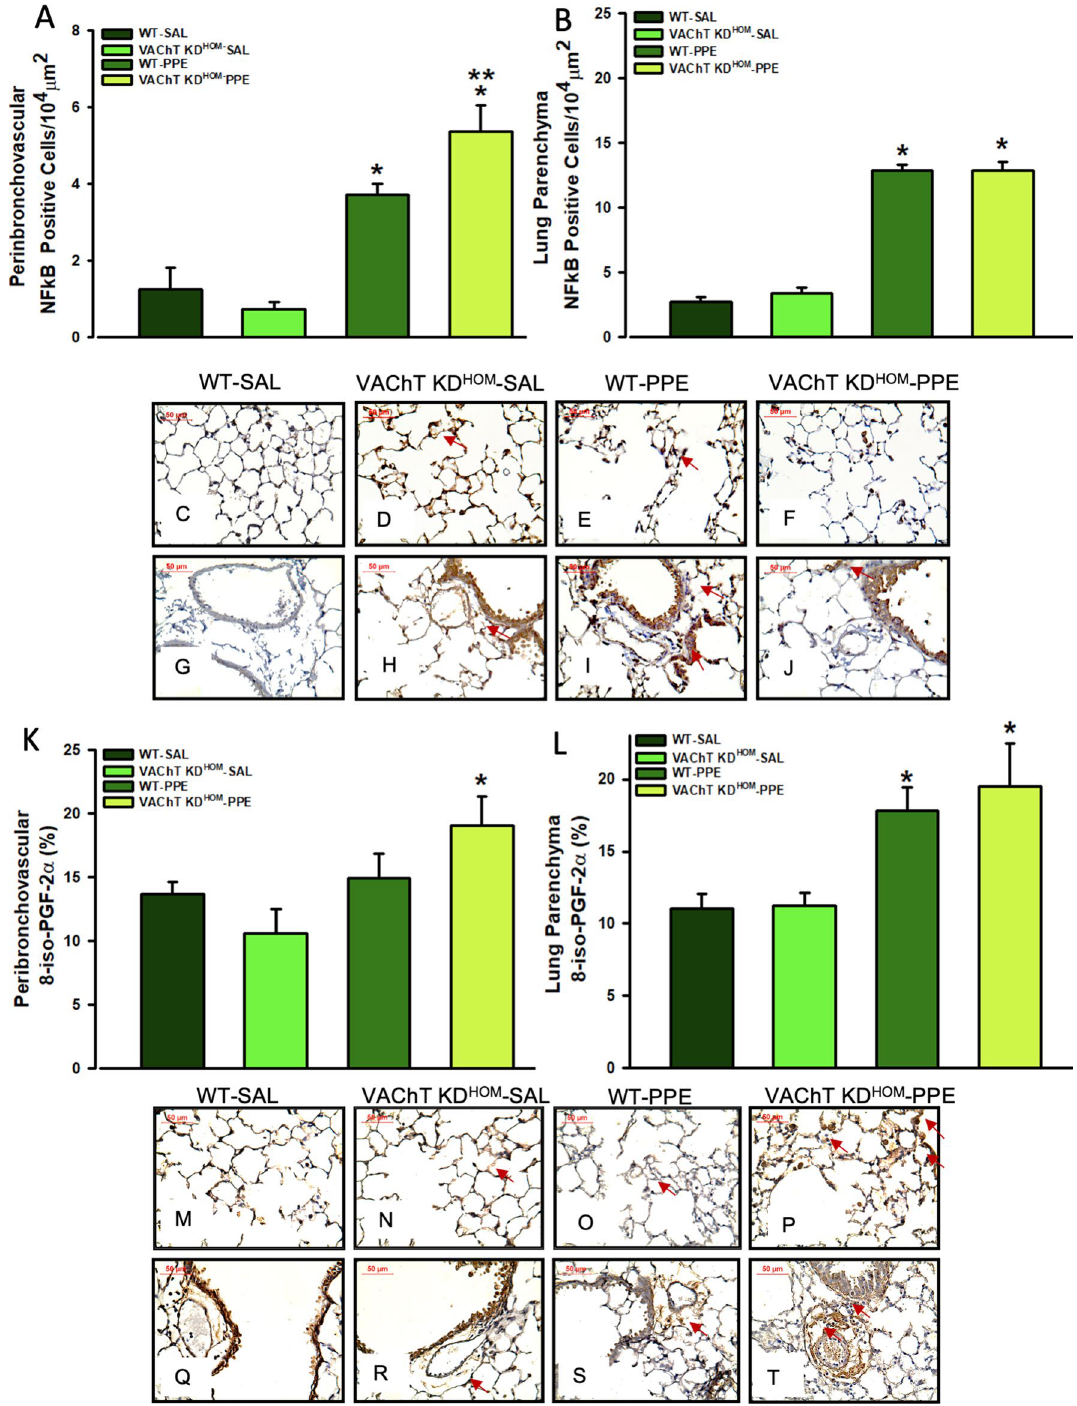
Figure 3. NF-κB positive cells and oxidative stress in peribronchovascular area and lung parenchyma. Data represent the mean ± S.E.M of six to seven animals per group. Number of positive cells to NF-κB in the peribronchovascular area ( A ), and in lung parenchyma ( B ) and representative photomicrography ( C – J ). The quantification of positive area for 8-iso-PGF-2α in the peribronchovascular area ( K ) and in lung parenchyma ( L ), and representative photomicrography ( M – T ). The NF-κB positive cells were detected by point counting technique and isoprostane positive area was detected using an image analysis system. Arrows point positive cells or area. **P < 0.05 compared to